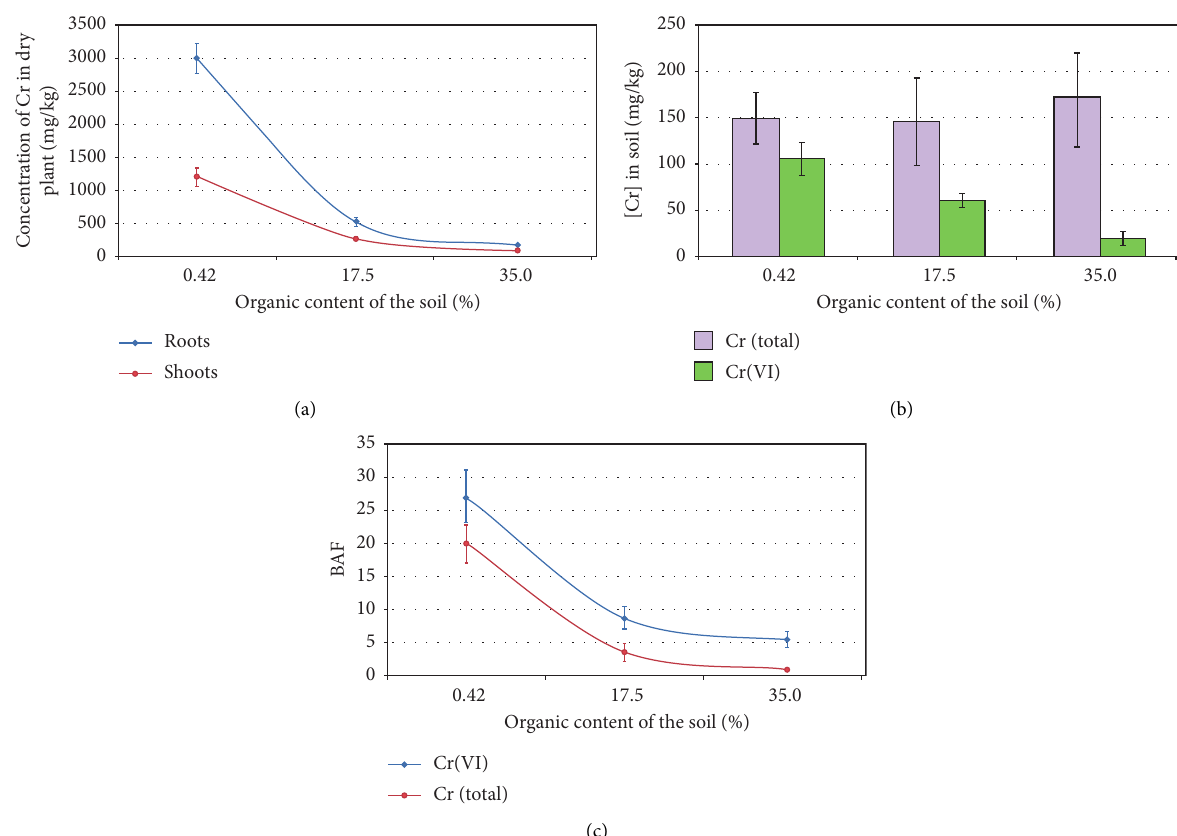
Figure 1: (a) Concentrations of total chromium in both shoots and roots of Portulaca ole racea, (b) concentrations of total chromium and Cr(VI) in the soil, and (c) change in bioaccumulation factors of total chromium and Cr(VI) at different levels of organic content in soil (mean of five replicates ± SE, 95% CLs).